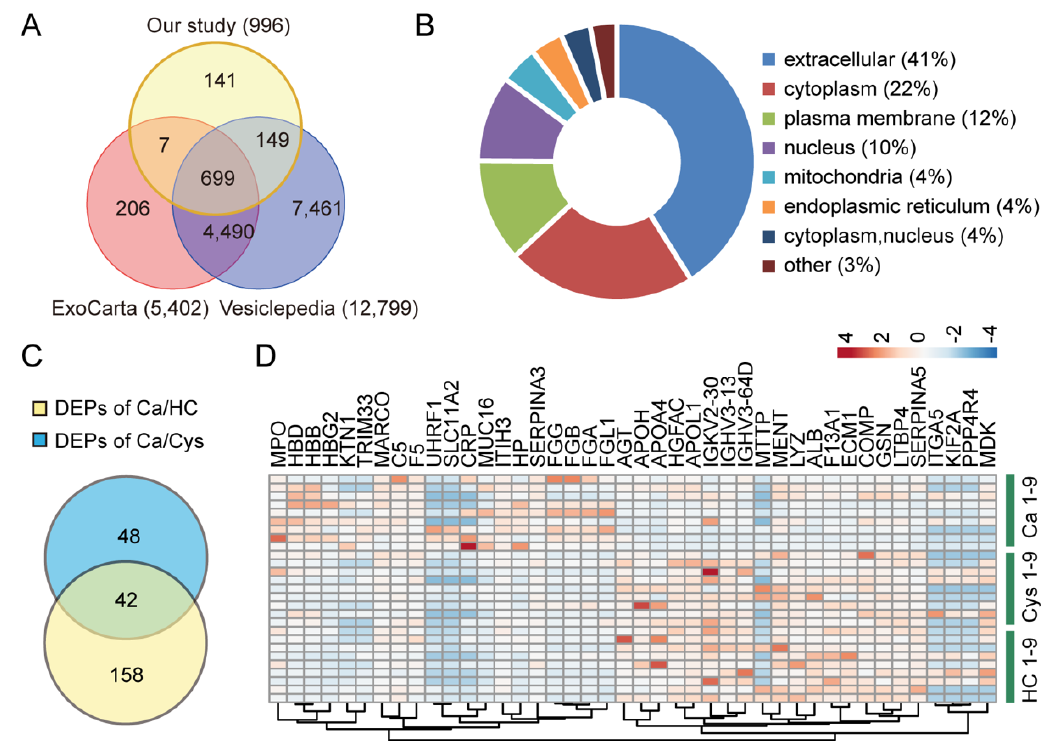
Figure 3. Proteomic profiles of sEVs. ( A ) Venn diagram showed the intersection between the proteins we identified and the proteins from the known databases ExoCarta and Vesiclepedia. ( B ) The circle chart displayed the cellular location of the identified proteins. ( C ) Venn diagram showed the intersection of the DEPs between the Ca group and the HC group and the DEPs between the Ca group and the Cys group. ( D ) Heat map of protein expression distribution of the above 42 DEPs from ( C ). Table 1. The upregulated DEPs existed in both Ca/Cys group and Ca/HC group (>1.2 fold). No.